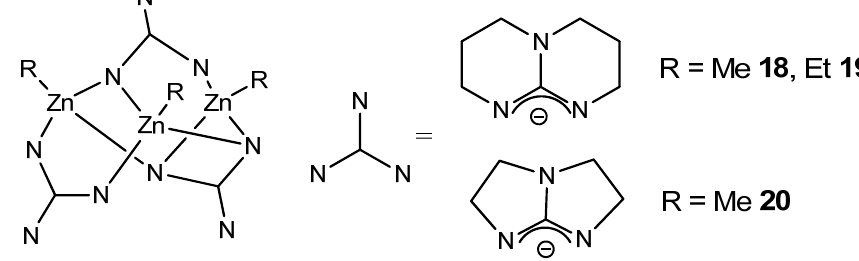
Figure 13. Bicyclic guanidinato complex acting as bridges in alkyl zinc complexes.